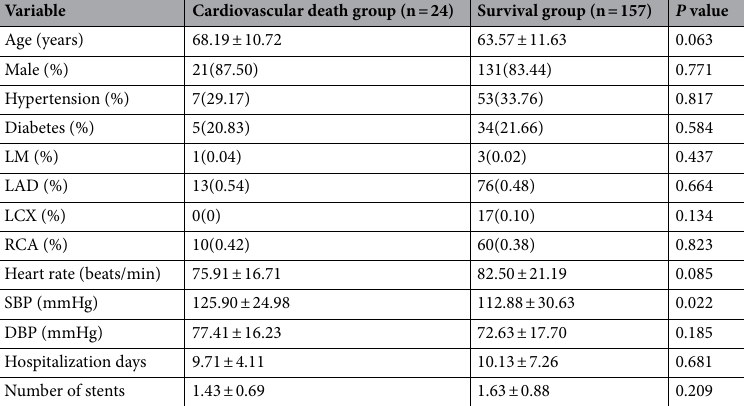
Table 1. Clinical and demographic properties of two groups. DBP, diastolic blood pressure; LAD, left anterior descending artery; LCX, left circumflex artery; LM, left main coronary artery; RCA, right coronary artery; SBP, systolic blood